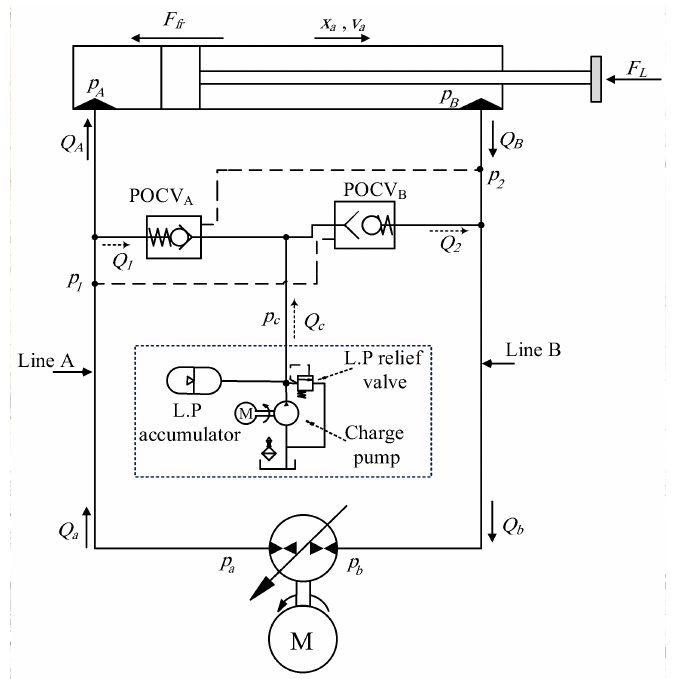
Figure 1. Circuit utilizing pilot-operated check valves in first quadrant of